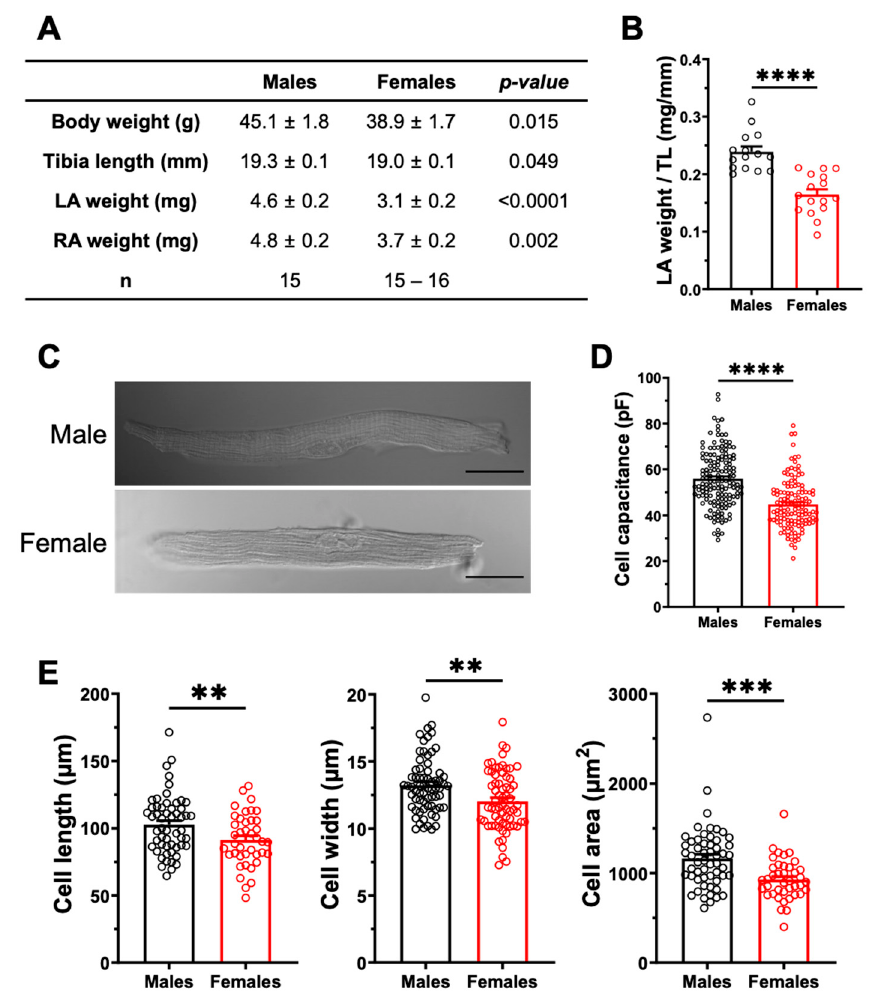
Figure 5. The left atria are heavier, and the atrial myocyte capacitances are greater in males. ( A ). Summary table of the numerical values of morphometric measurements of male and female mice. ( B ). The scatter plot displaying left atria weight normalized to tibia length (TL) shows a higher ratio in male than in female mice (M: 0.24 ± 0.01 mm/mg, n = 15; F: 0.16 ± 0.01 mm/mg, n =